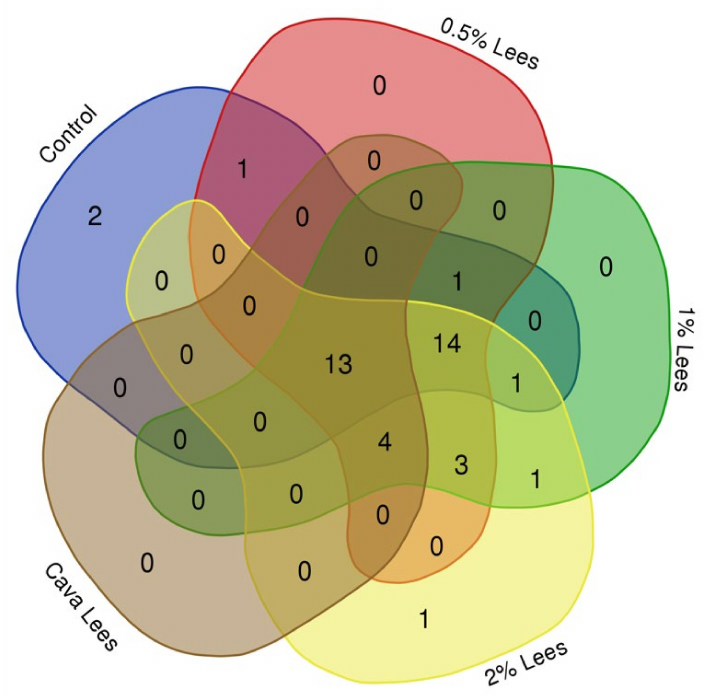
Figure 6. Venn diagram of the volatile compounds shared between the different sourdoughs produced and Cava